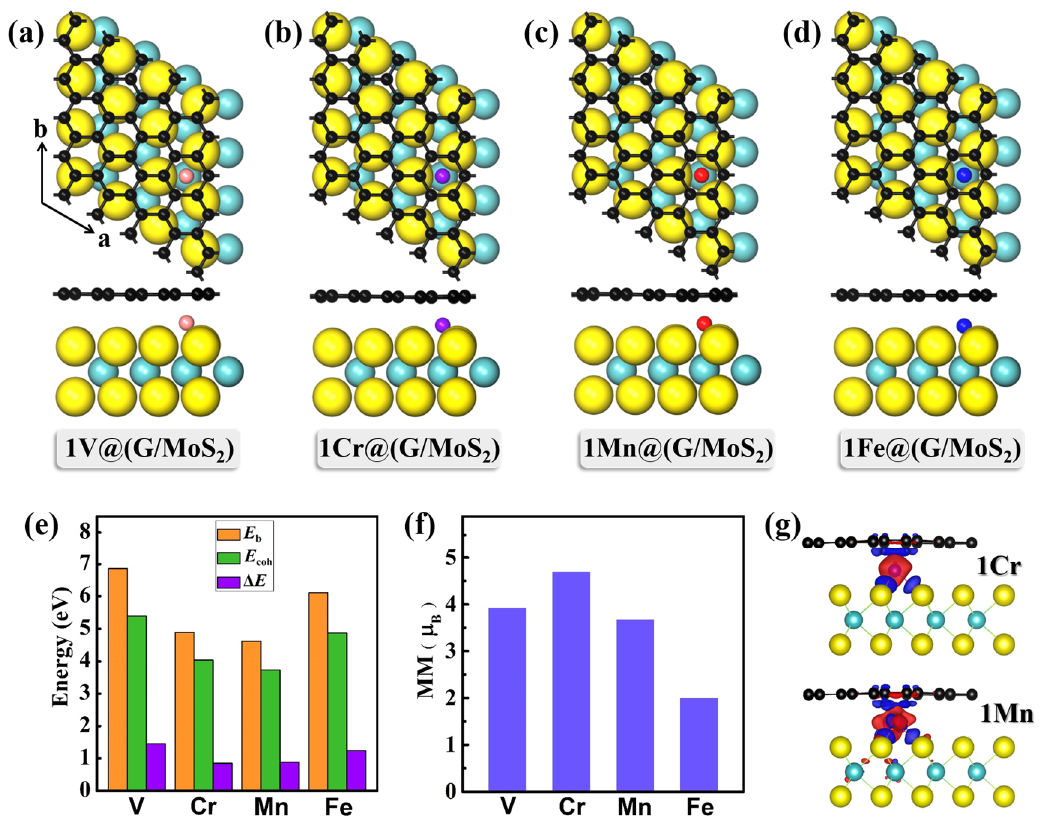
Figure 1. ( a – d ) The lowest energy structures of 1TM@(G/MoS 2 ) (TM = Ti, V, Cr, Mn). Green, yellow, black, pink, purple, red, and blue balls represent Mo, S, C, V, Cr, Mn, and Fe atoms, respectively. ( e ) The binding energy ( E b ) of one TM atom between G and MoS 2 , the cohesive energy of TM atoms in their metal crystals ( E coh ), and the energy difference between them (Δ E = E coh − E b ). ( f ) Magnetic moments (MM) of 1TM@(G/MoS 2 ). ( g ) The charge density difference (CDD) plots of 1Cr@(G/MoS 2 ) and 1Mn@(G/MoS 2 ).